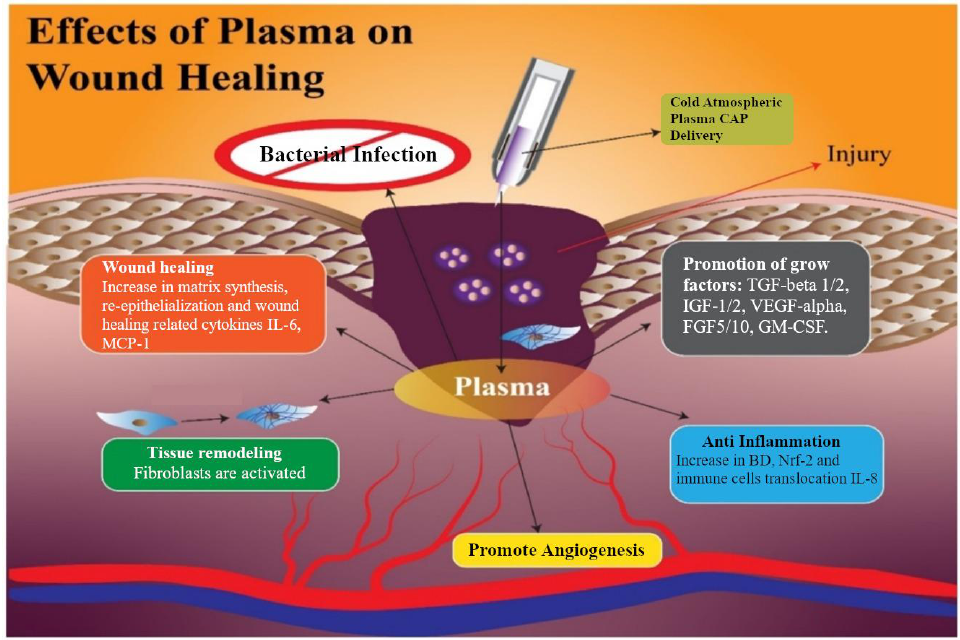
Figure 6. Processes initiated by exposure of LTP and associated wound healing [184].